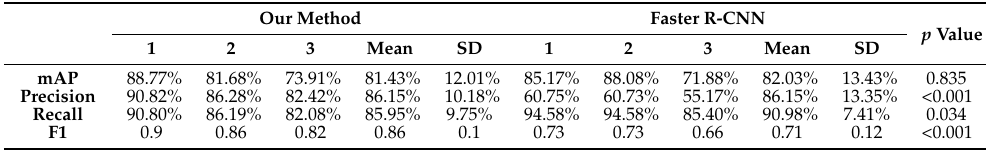
Table 2. Quantitative results of hierarchical YOLO detection method(Our method) and Faster R-CNN detection method on test